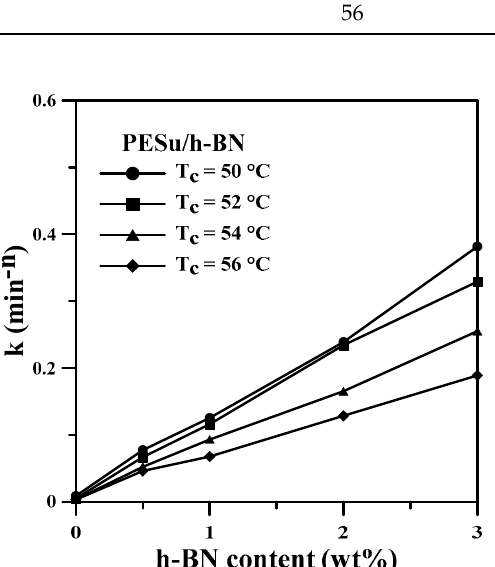
Figure 4. The Avrami plots for isothermal crystallization for various PESu/h ‐ BN composites: ( a ) 100/0; ( b ) 99.5/0.5; ( c ) 99/1; ( d ) 98/2; and ( e ) 97/3.